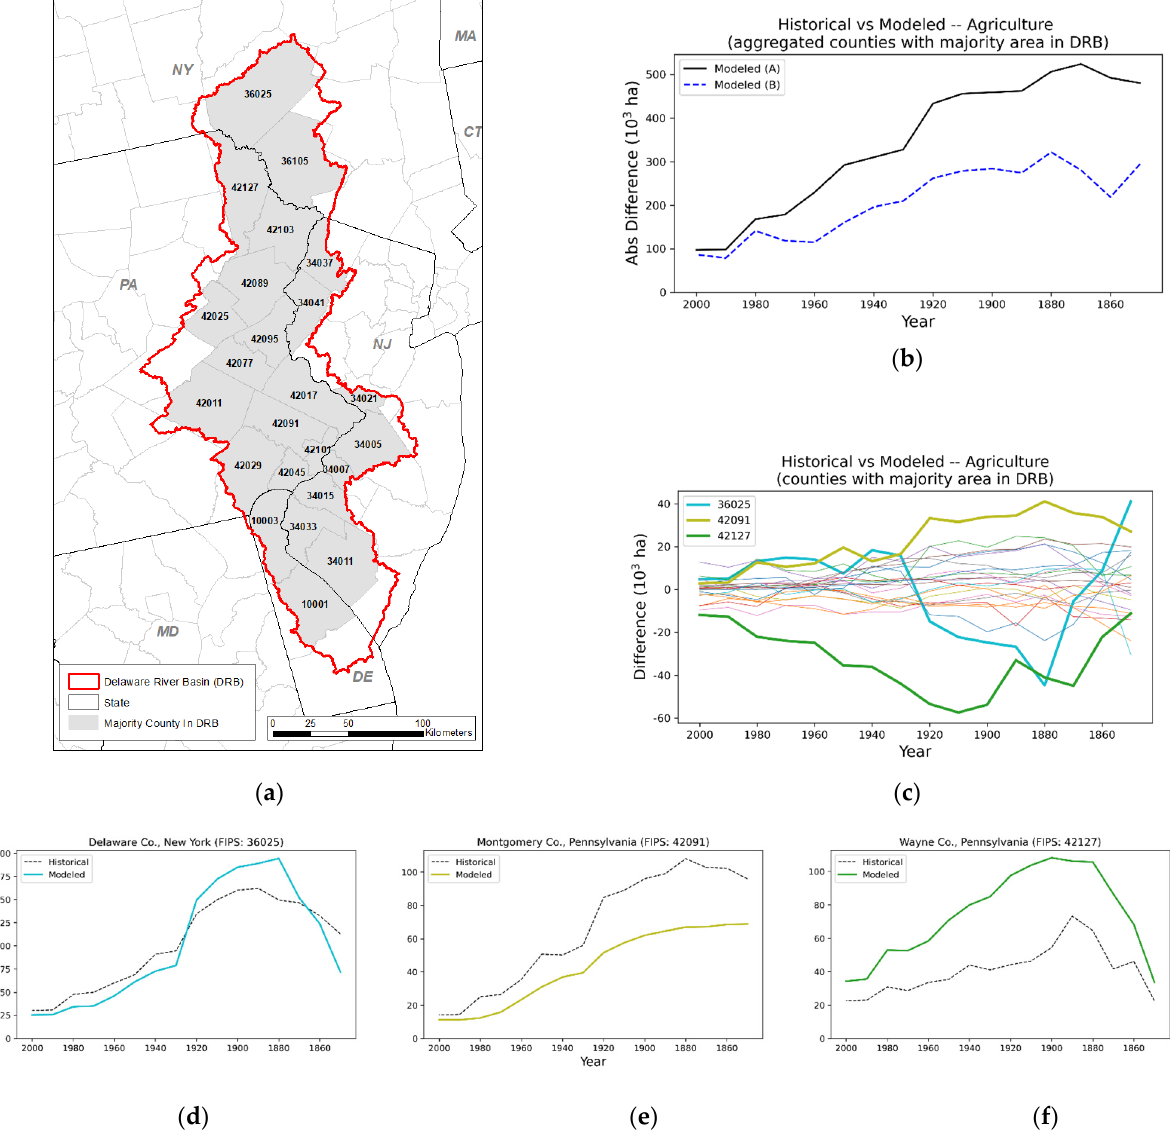
Figure 9. ( a ) Counties with majority area inside the study area; ( b ) time series for model runs both without (A) and with (B) incorporation of historical dataset plotting the absolute difference in area (hectares) between modeled and historical land-in-agriculture summed for counties with majority area inside the study region; ( c ) county-level disagreement with historical cropland; ( d – f ) modeled agriculture vs. historical for the three counties with the most disagreement with historical cropland